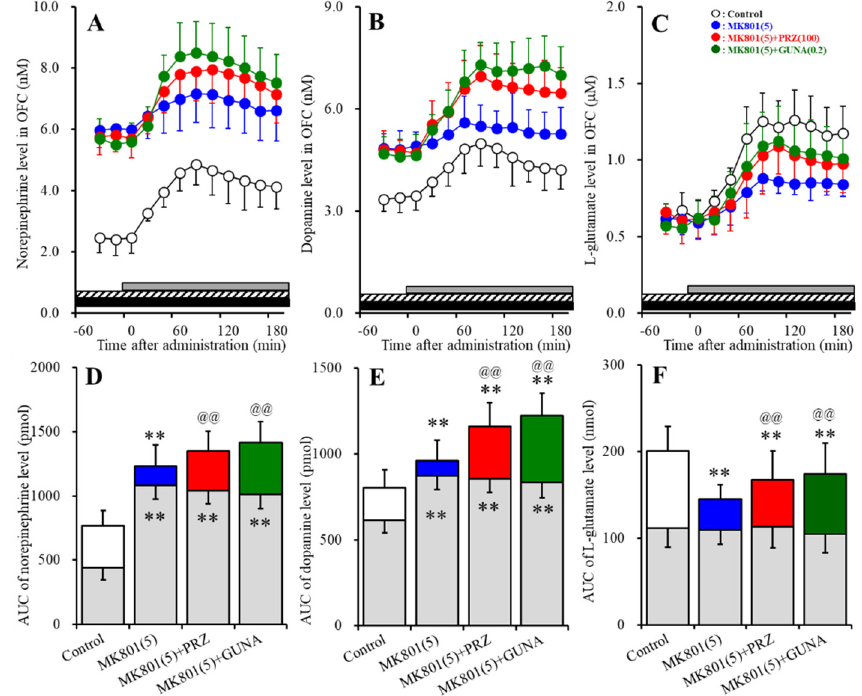
Figure 8. Effects of local administration of MK801 into the LC, PRZ and GUNA into the RTN on α -amino-3-hydroxy-5-methyl-4-isoxazolepropionic acid (AMPA)-induced releases of norepinephrine ( A , D ), dopamine ( B , E ) and L-glutamate ( C , F ) in the OFC. Ordinate: mean ± SD (n = 6) of extracellular levels of norepinephrine (nM), dopamine (nM) and L-glutamate (μM); abscissa: time after AMPA administration (min). Closed and stripped bars indicate perfusion with 5 μM MK801 into the LC, and 100 μM PRZ or 0.2 μM GUNA into the RTN, respectively. Gray bars indicate perfusion with 100 μM AMPA into the MDTN. ( D – F ) indicate the AUC values of extracellular levels of norepinephrine (pmol), dopamine (pmol) and L-glutamate (nmol) after perfusion with AMPA (from 20 to 180 min), based on ( A – C ), respectively. Gray columns represent the AUC values before perfusion with AMPA (basal release). ** p < 0.01; relative to control, @@ p < 0.01; relative to MK801 (5 μM) by MANOVA with Tukey’s post hoc test.